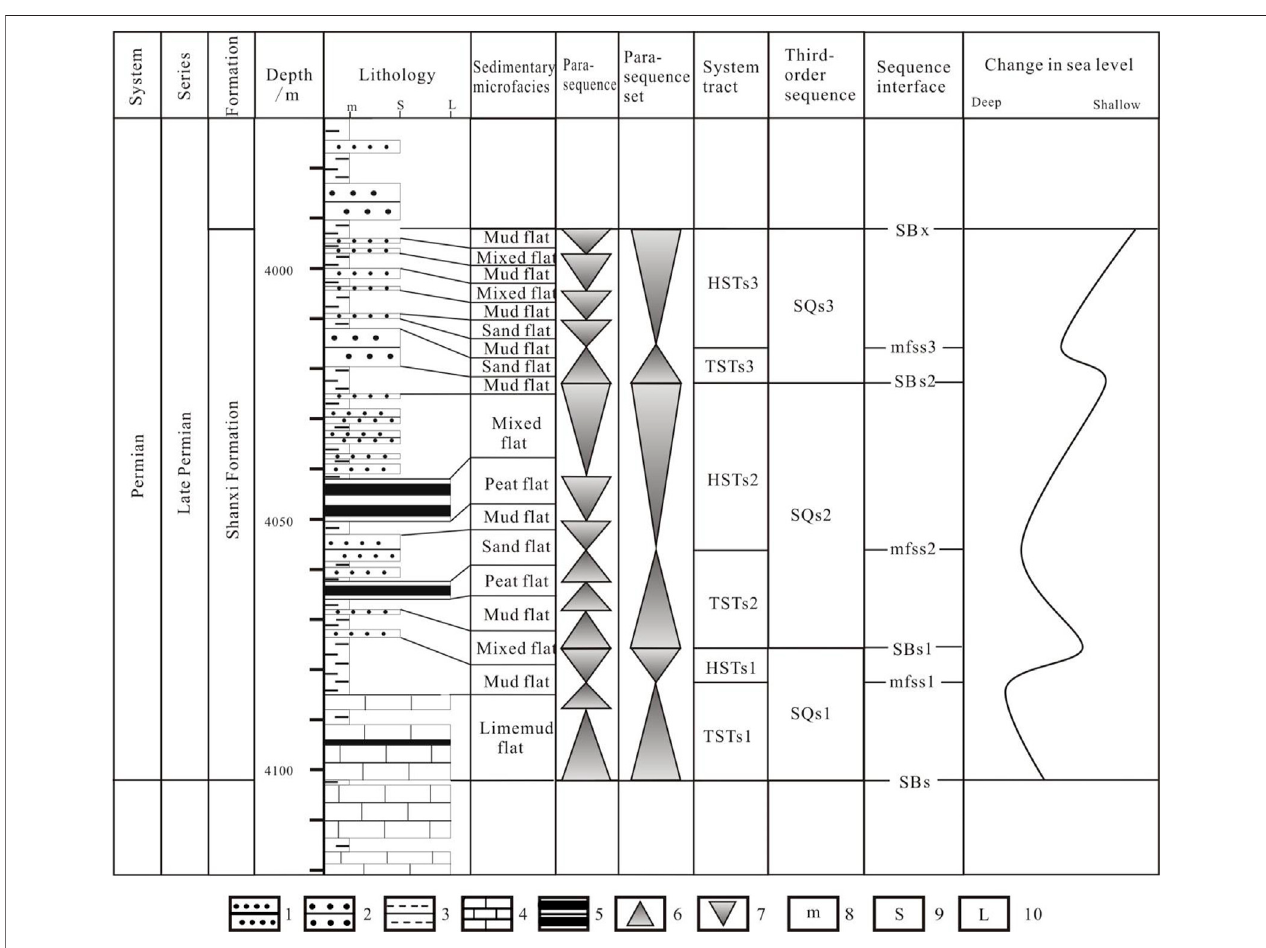
FIGURE 3 | Division of sequence stratigraphic framework of Shanxi Formation (well A) 1. Fine sandstone; 2. Medium sandstone; 3. Mudstone; 4. Limestone; 5. Coal seam; 6. Rising of sea level; 7. Dropping of sea level; 8. Width of mudstone; 9. Width of sandstone; 10. Width of limestone.